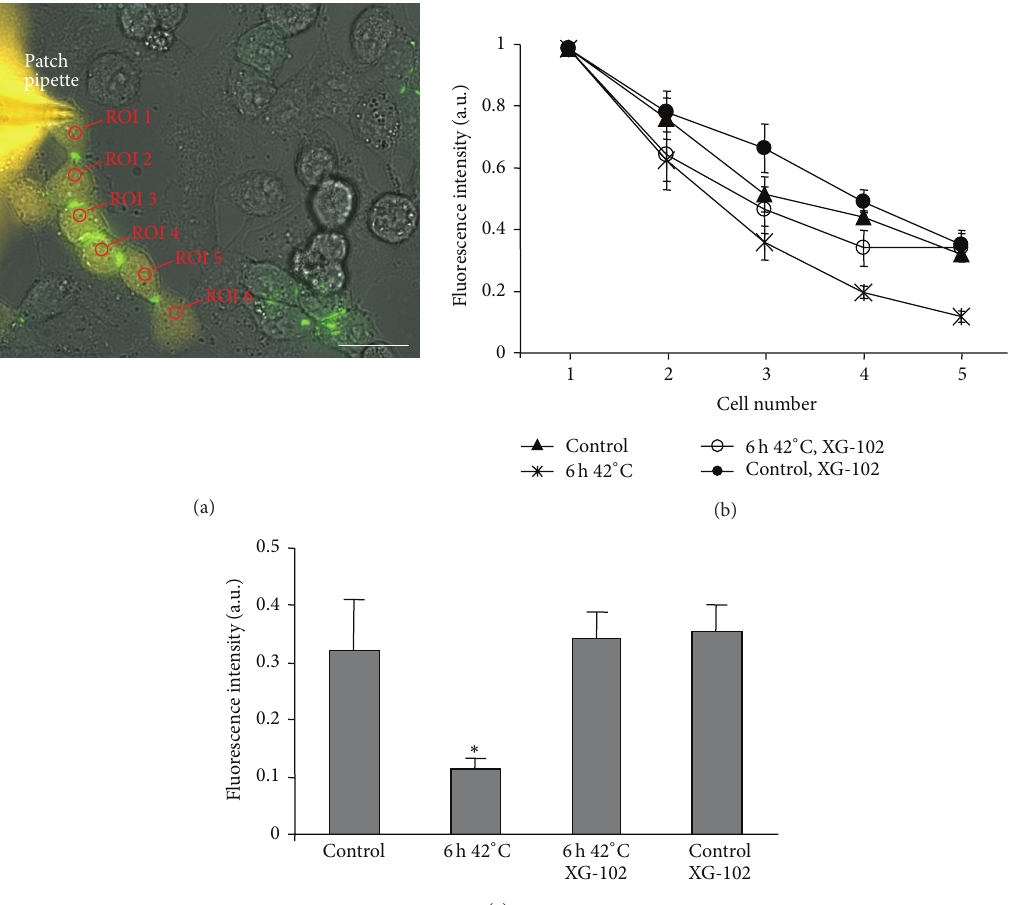
Figure 6: The effect of hyperthermia on Cx43-EGFP GJIC in HeLa cells. (a) LY was introduced through the patch pipette into the first cell of six cells in a row. (b) Kinetics of LY diffusion under different conditions. (c) LY fluorescence intensity in the fifth cell 3 min after its introduction into the first cell under control and hyperthermic conditions in the absence and presence of XG-102 (4 𝜇 M). 𝑛 = 8 in each set of experiments. Scale bar 25 𝜇 m. ∗ = 𝑃 < 0.05 , ANOVA followed by post hoc Dunnet’s